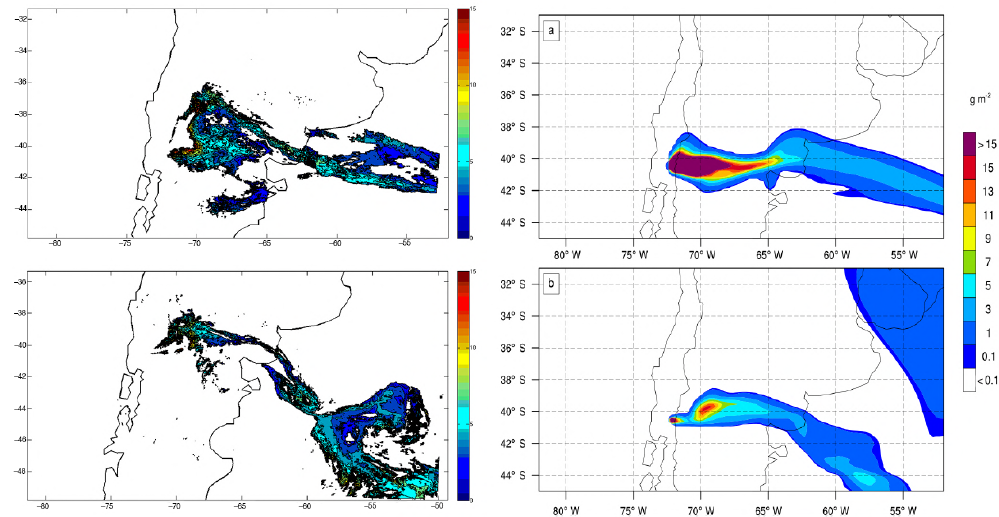
Figure 4. Left panels: mass loadings (gm − 2 ) of the 2011 Caulle volcanic ash cloud from the MODIS-based retrievals (Osores et al., 2015). Right panels: predicted column mass (gm − 2 ) with NMMB-MONARCH-ASH for (a) 6 June at 14:25UTC and (b) 8 June at 14:15UTC.